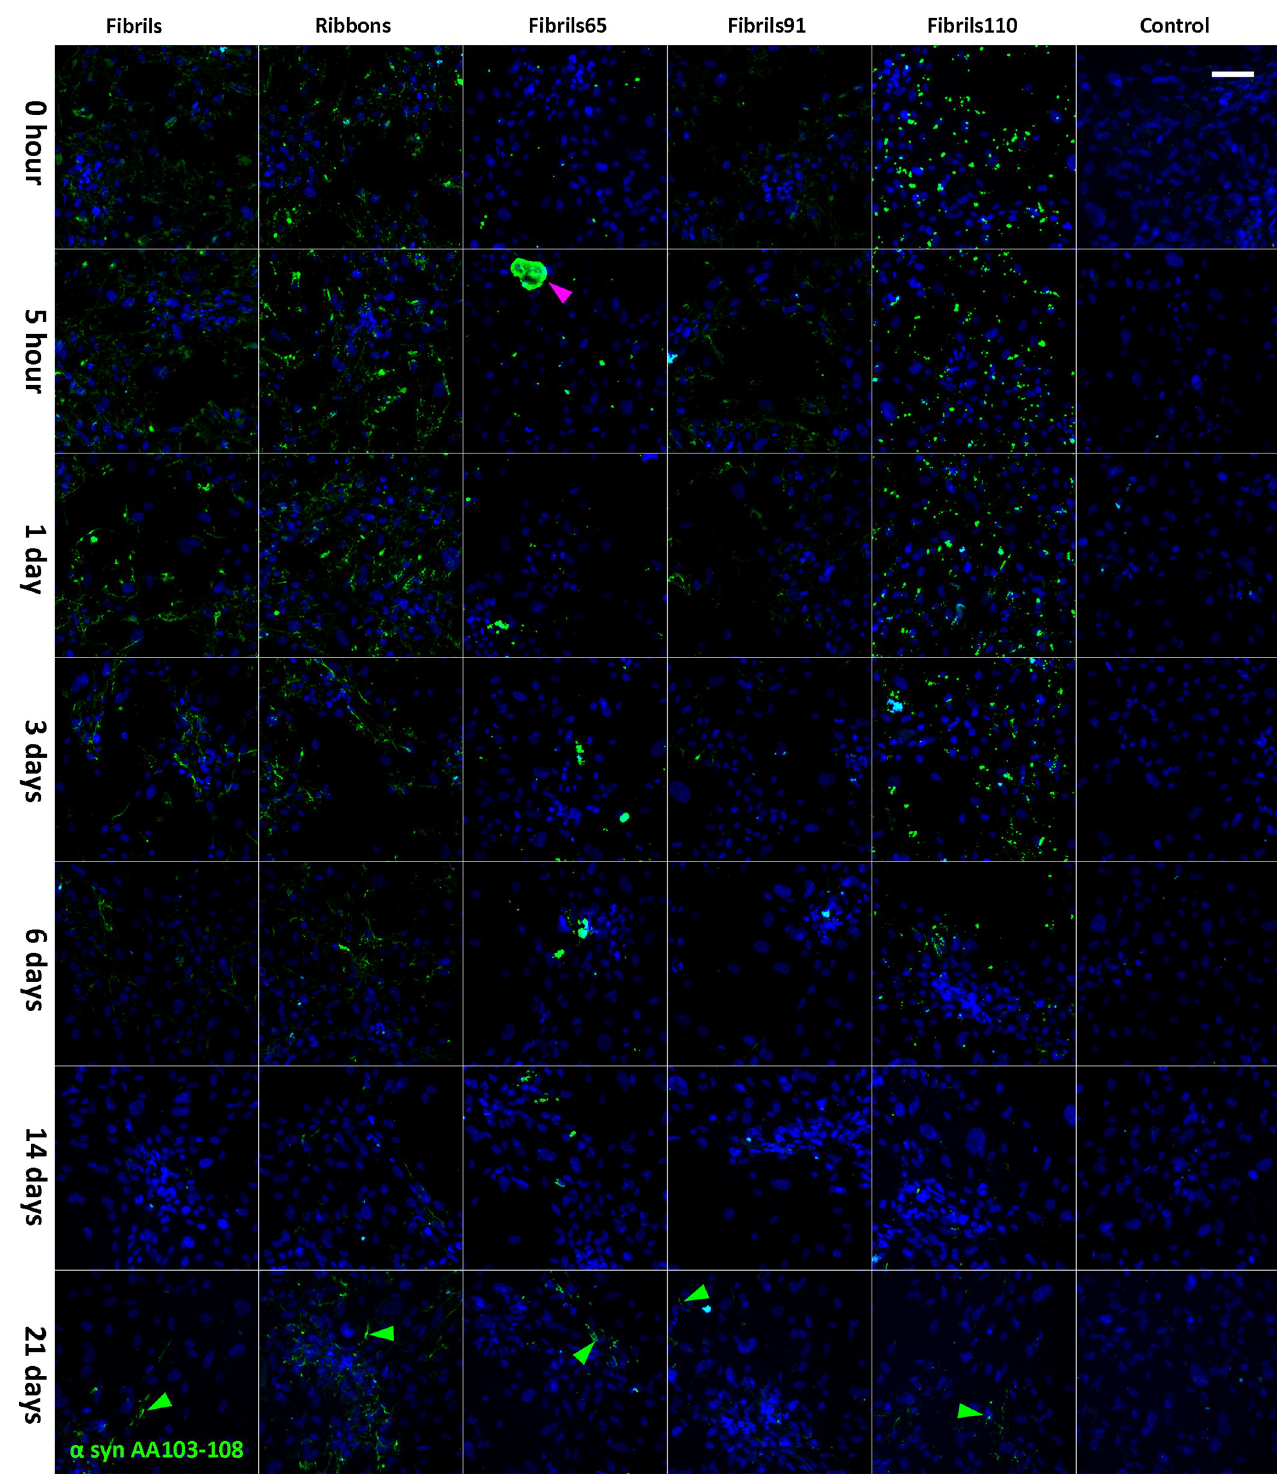
Fig 3. Immunofluorescent labelling of α -syn strains in pericytes with α -syn specific antibodies AA103-108 (green) after pre-treatment with 100nM Fibrils, Ribbons, fibrils65, fibrils91 and fibrils110. Large aggregates were occasionally found for fibrils65 (magenta arrow). The scale bar represents 100 μ m.